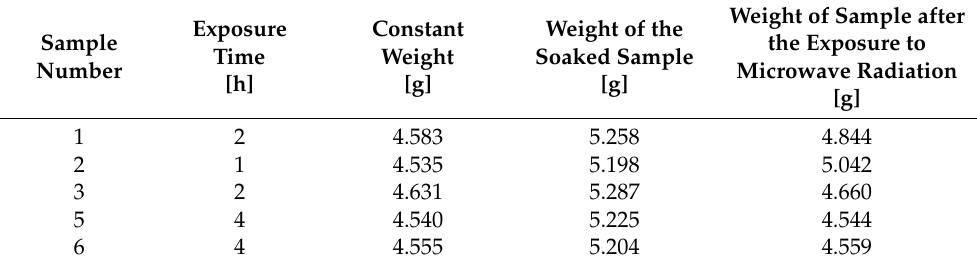
Table 4. Weight summary of each sample after drying, soaking, and exposure to microwave radiation; these samples were exposed to 10 radiation